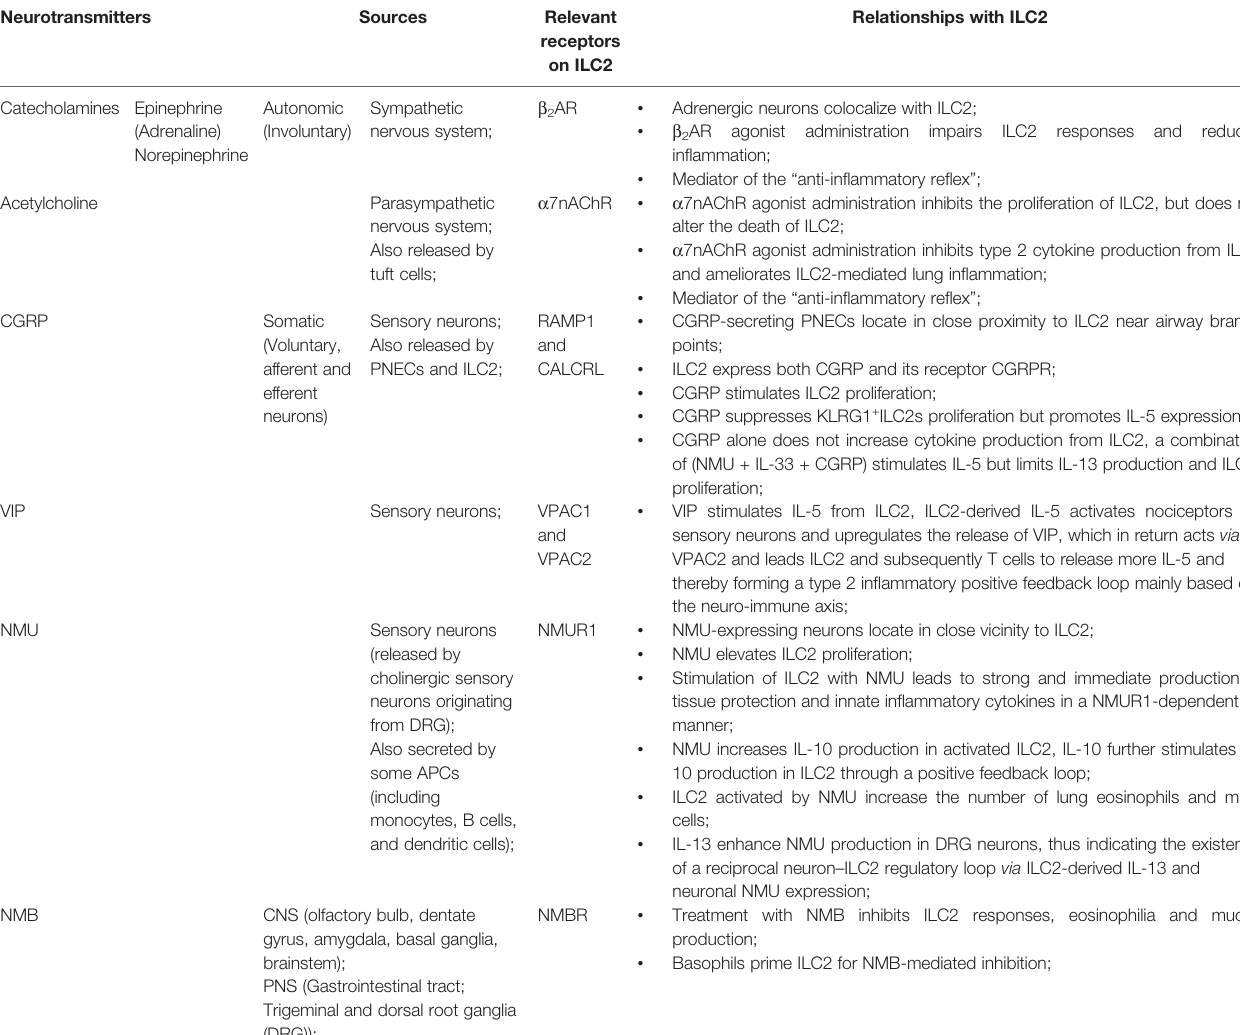
TABLE 1 | Sources, receptors on ILC2, and relationships with ILC2 of several neurotransmitters. Neurotransmitters